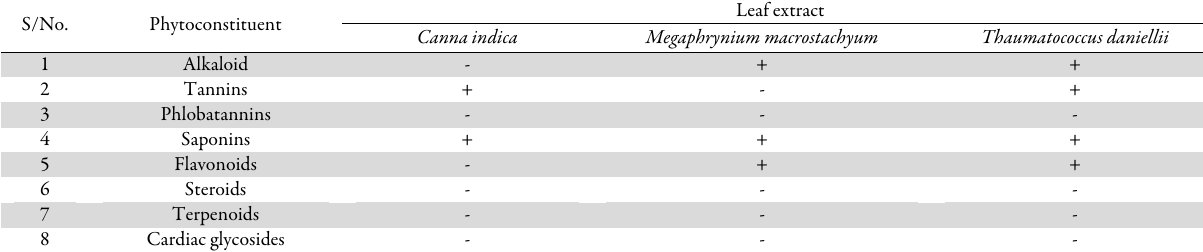
Table 2a. Qualitative phytochemical screening of leaf extracts of test plants S/No.